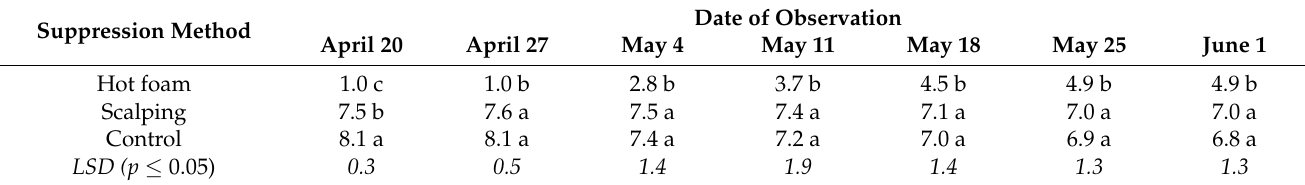
Table 5. Turf color (1–9): mean effect of Lolium perenne suppression